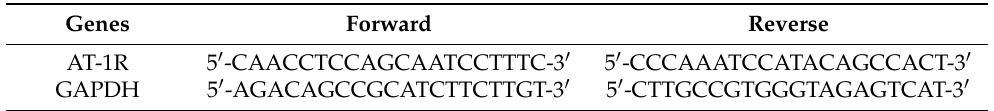
Table 1. Primer sequences used for quantitative Real-time PCR. Genes